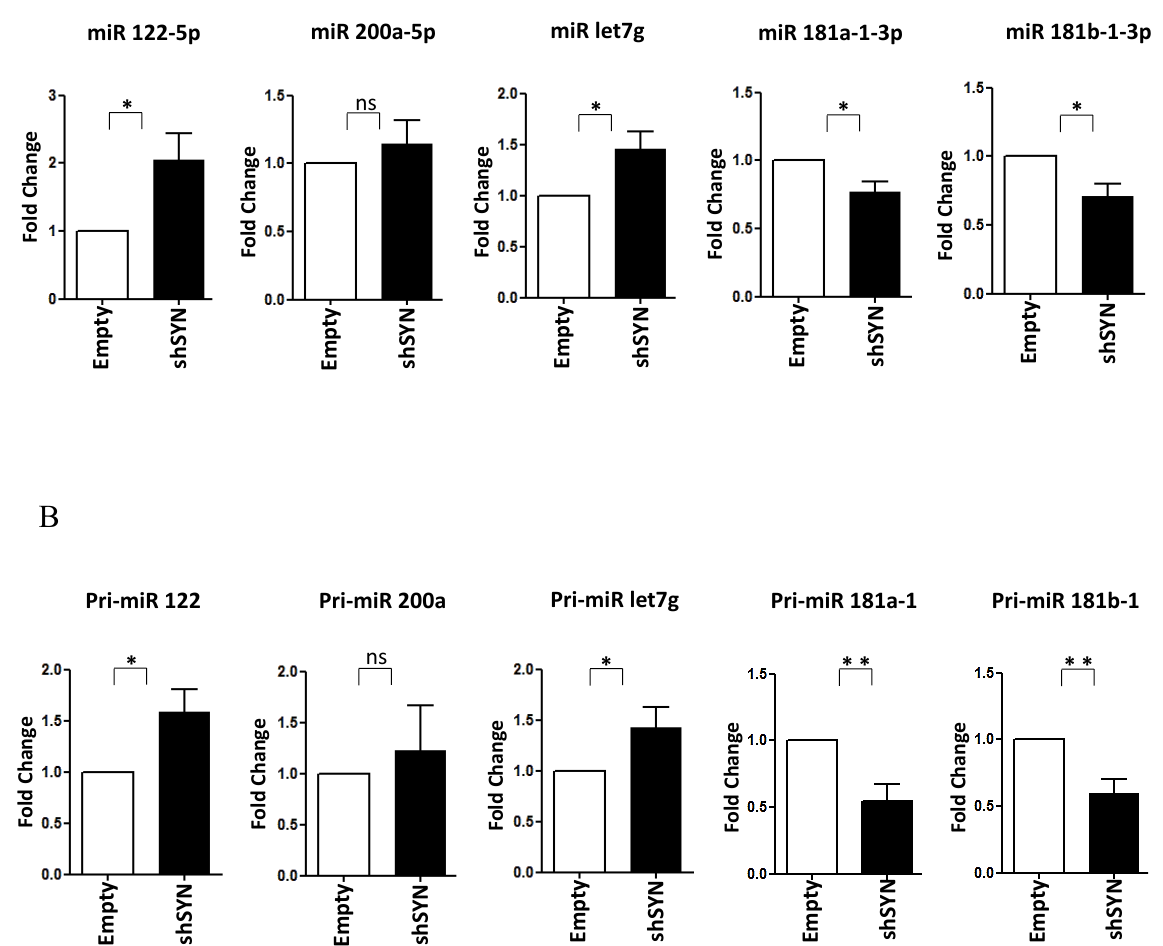
Figure 4. SYNCRIP controls anti and pro-EMT miRNA levels in hepatoma cells. ( A ) qRT-PCR analysis of intracellular levels of anti-EMT microRNAs ( miR-122-5p , miR-200a-5p , and let7-g-5p )